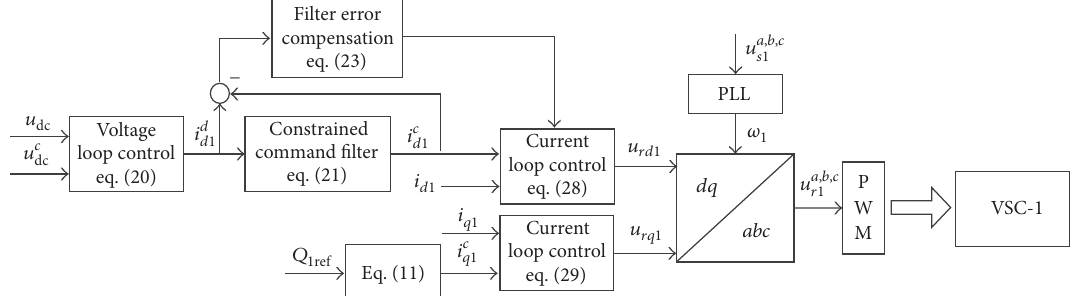
Figure 3: Block diagram of command-filtered backstepping designed for